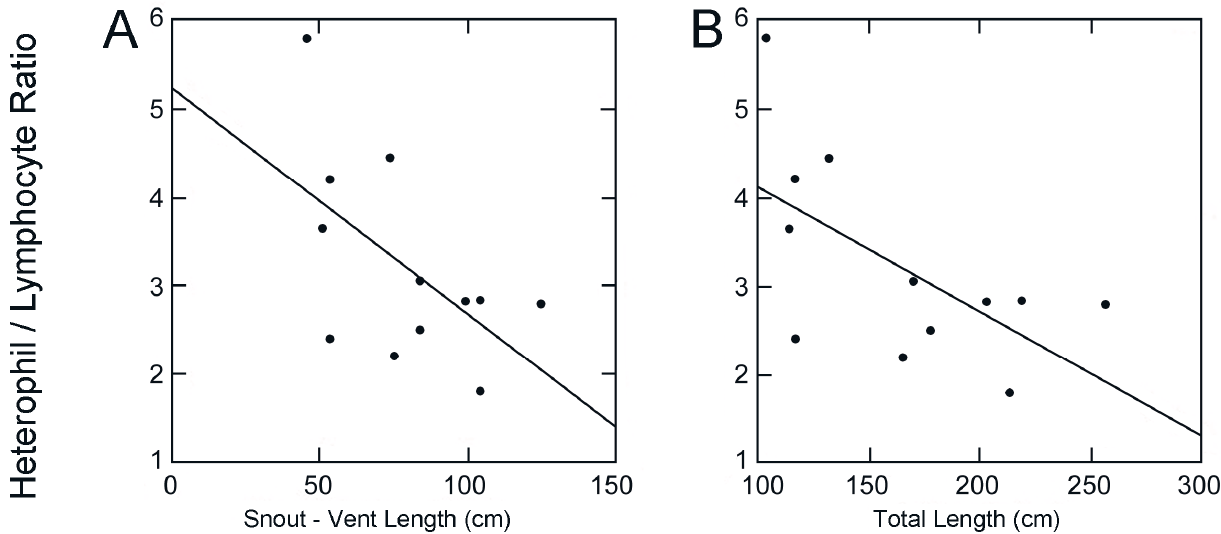
Figure 2. Scatter plots with best-fit lines showing correlations between alligator morphometrics (total length and snout-vent length) and heterophil to lymphocyte ratios post oil inundation (Total length: p = 0.033, f = 6.06, Snout-vent length: p = 0.0505, f = 4.94). Baseline data from pre-oil disturbance revealed H:L ratios of 1.56, 1.37, 1.25 and 1.24, for the